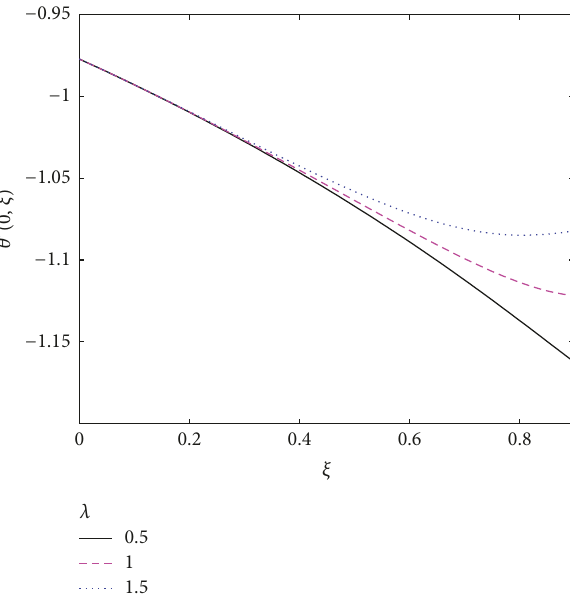
Figure 17: Effect of Pr on 𝑔 󸀠 (0,𝜉) . ( 𝜎 = 𝛾 = 0.5, 𝜆 = 1, Sc = 2, ℏ = −0.5 ).